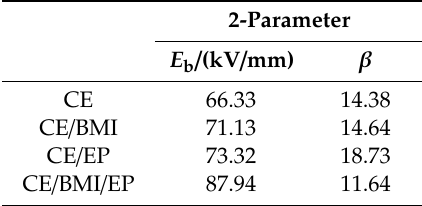
Table 2. Weibull distribution fitted 2-parameters in 95% confidence interval from the tested dielectric breakdown fields: characteristic breakdown field E b at 63.2% probability and shape parameter β